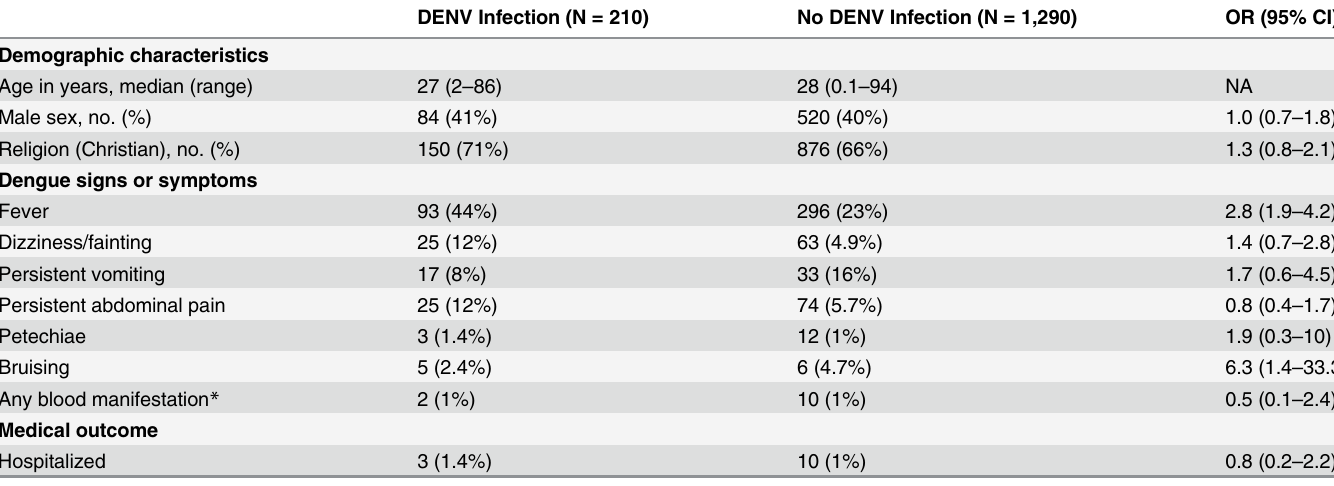
Table 1. Demographic characteristics, symptoms and medical outcomes reported by 1,500 residents of Tudor, Mombasa, participating in serolog- ic survey for dengue virus infection (DENV), April through May